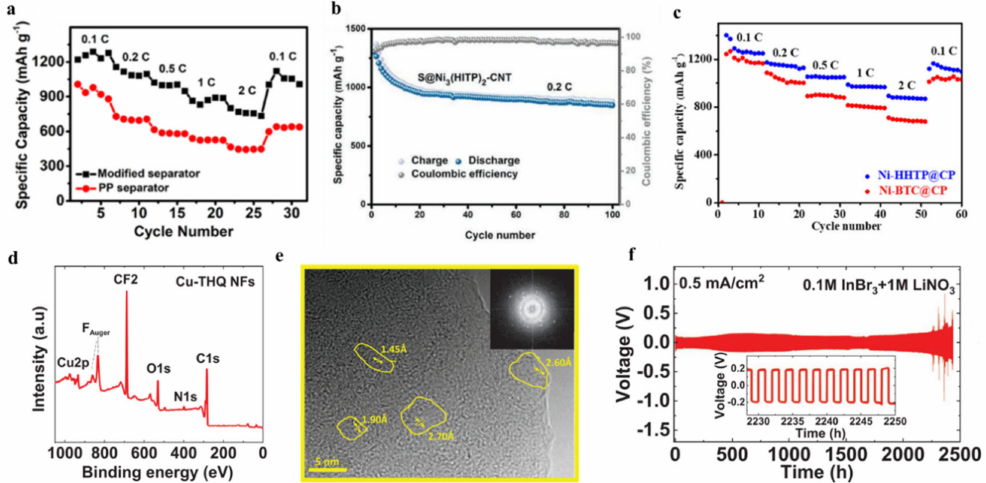
Figure 11. ( a ) Rate performance of Li–S batteries with PP and Ni 3 (HITP) 2 modified separators at different current densities of 0.1, 0.2, 0.5, 1, 2 and 0.1 C. Reproduced with permission from Ref.